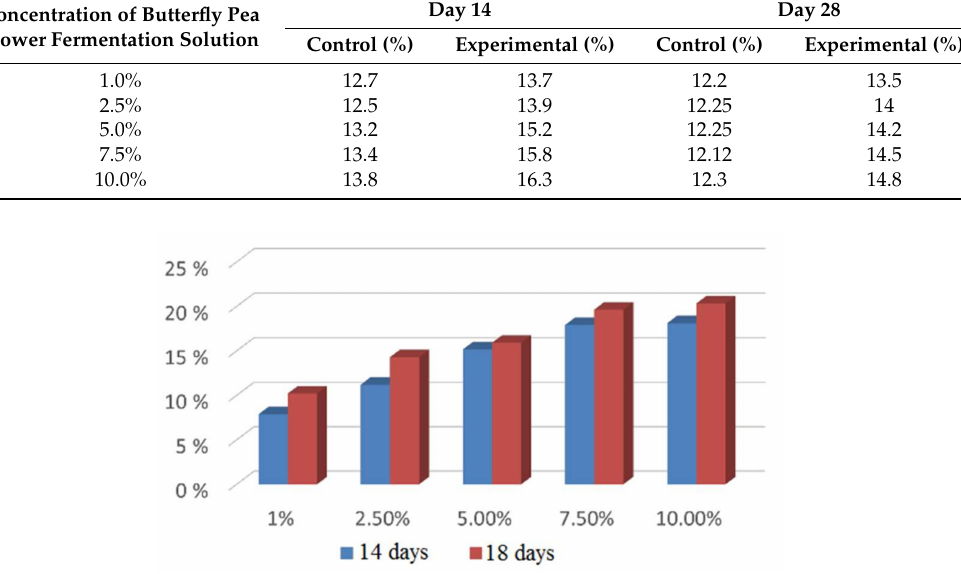
Figure 4. Moisture improvement rates (%) of the fermentation solutions at different concentrations after 14 days and 28 days of use.